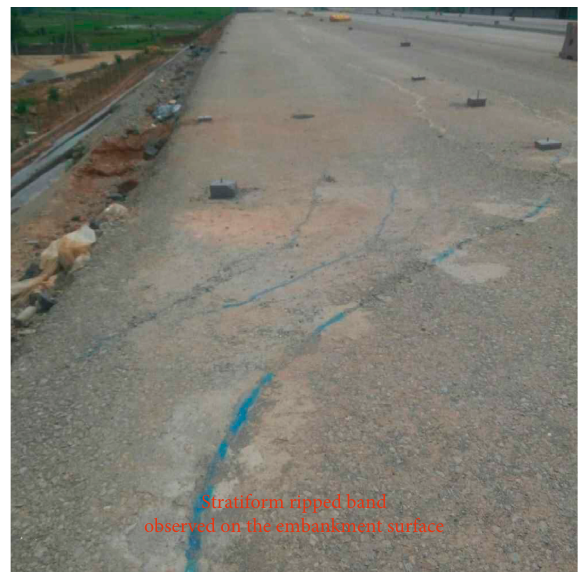
Figure 22: Failure pattern observed at the